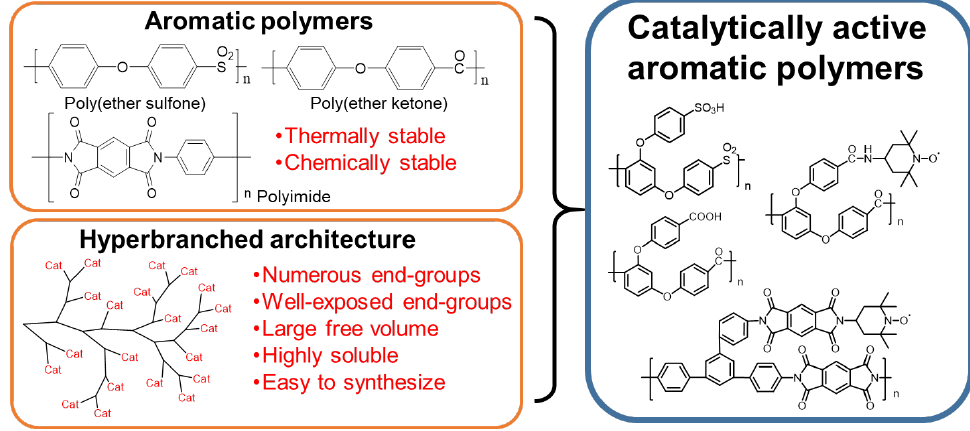
Figure 1. Concept of hyperbranched aromatic polymers for use in catalysis.